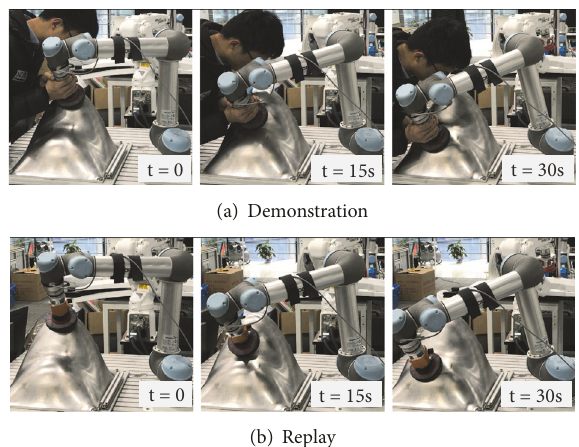
Figure 8: Demonstration of polishing. (a) Kinesthetic teaching for a trajectory. (b) Replay the teaching movement and record position and force